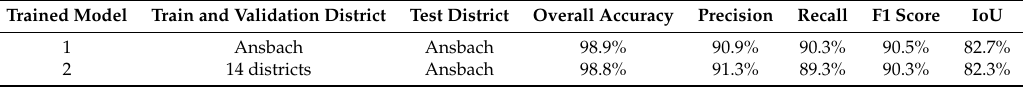
Table 6. Accuracy of two different trained models evaluated in the district of